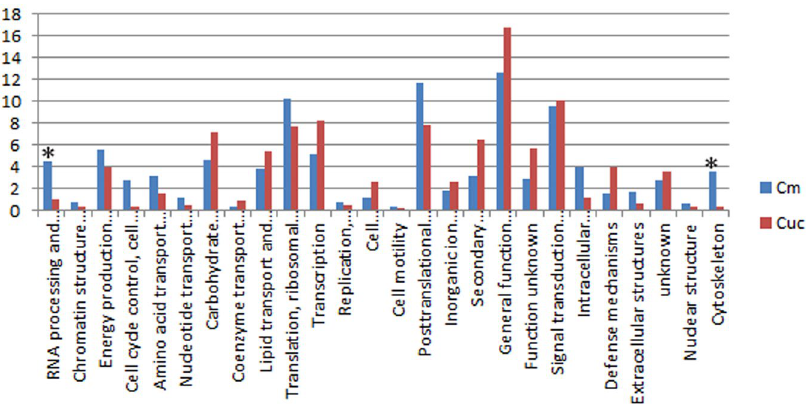
detected, in which Minc08210 was specifically expressed in 28d treatment. The highest expression levels were detected for the gene encoding Minc08986 , a fatty acid and retinol-binding protein. The Minc08986 -encoding gene was highly expressed in all the treatment libraries and its expression levels peak in the 28d treatment librar- ies, suggesting that Minc08986 may play important roles in nematode infections. The co-expression net of Cm pathogen related DEUs and Mi effectors were analyzed (Fig. 9B). The net con- tains 13 Cm pathogen related genes and three known Mi effectors ( Minc06489 , Min06490 and Minc14900 ). The co-expression net included two transcriptional factors ( WRKY2 and MYB), PAMPs-associated genes ( BAK1 ,